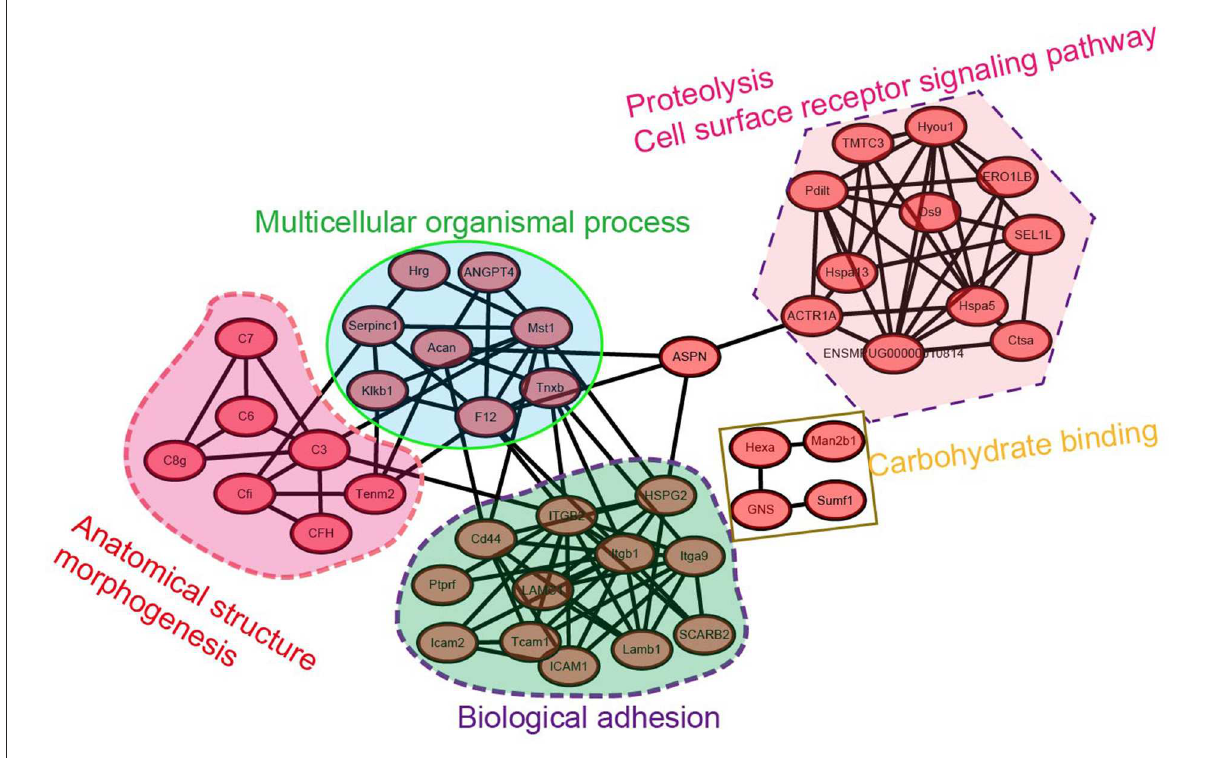
FIGURE7 Protein-protein interaction network analysis for the N-glycoproteome of mink testis during seasonal spermatogenesis.